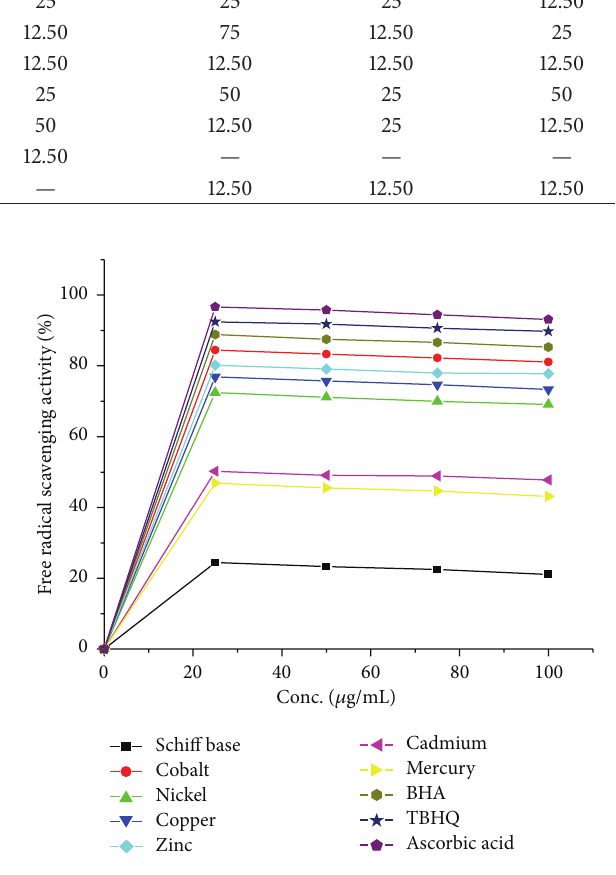
Figure 4: Antioxidant results of Schiff base and its metal (II)